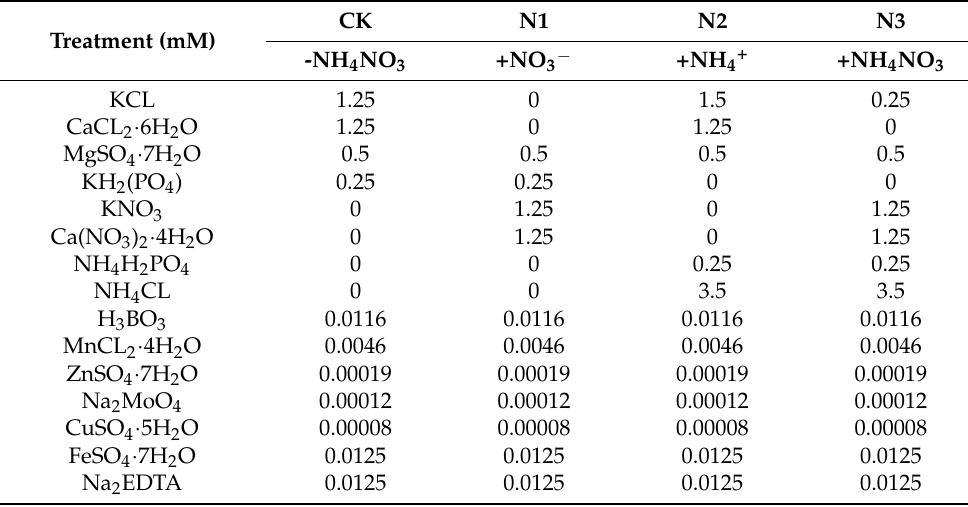
Table 3. Nutrient solution composition of nitrogen form